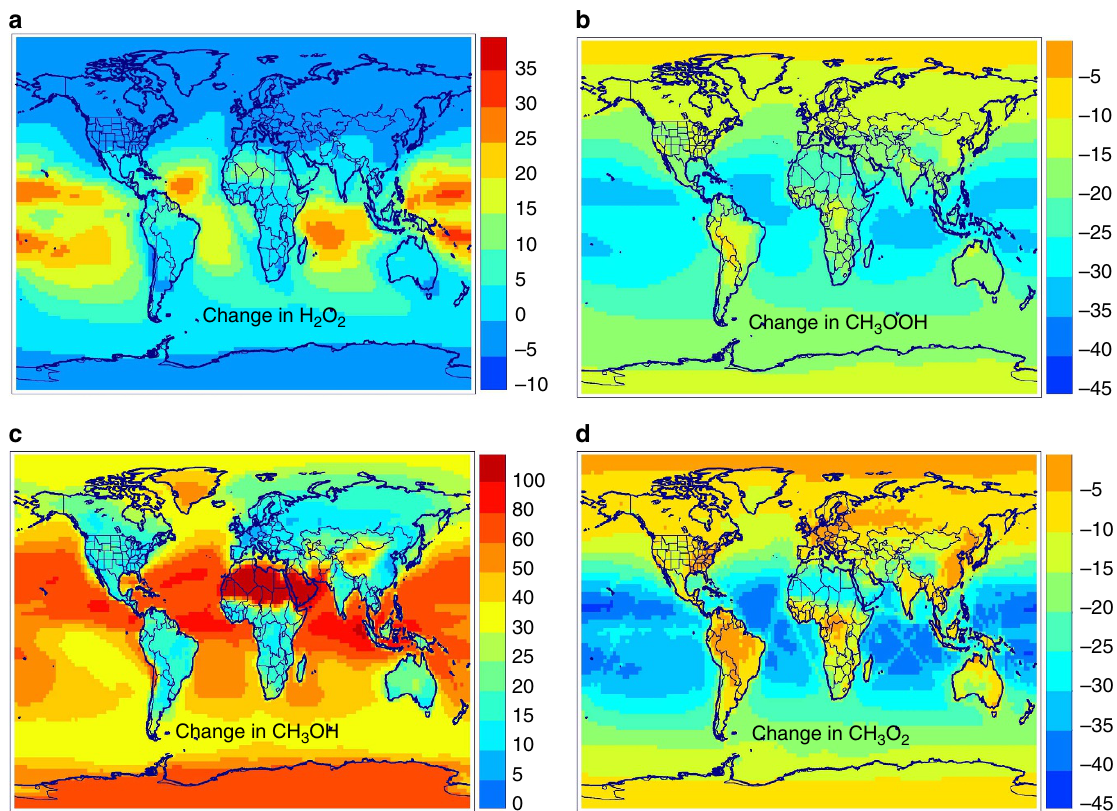
Figure 4 | Impact of CH 3 O 2 þ OH on key compounds abundances. Annually averaged modelled changes (in %) in near-surface concentrations of